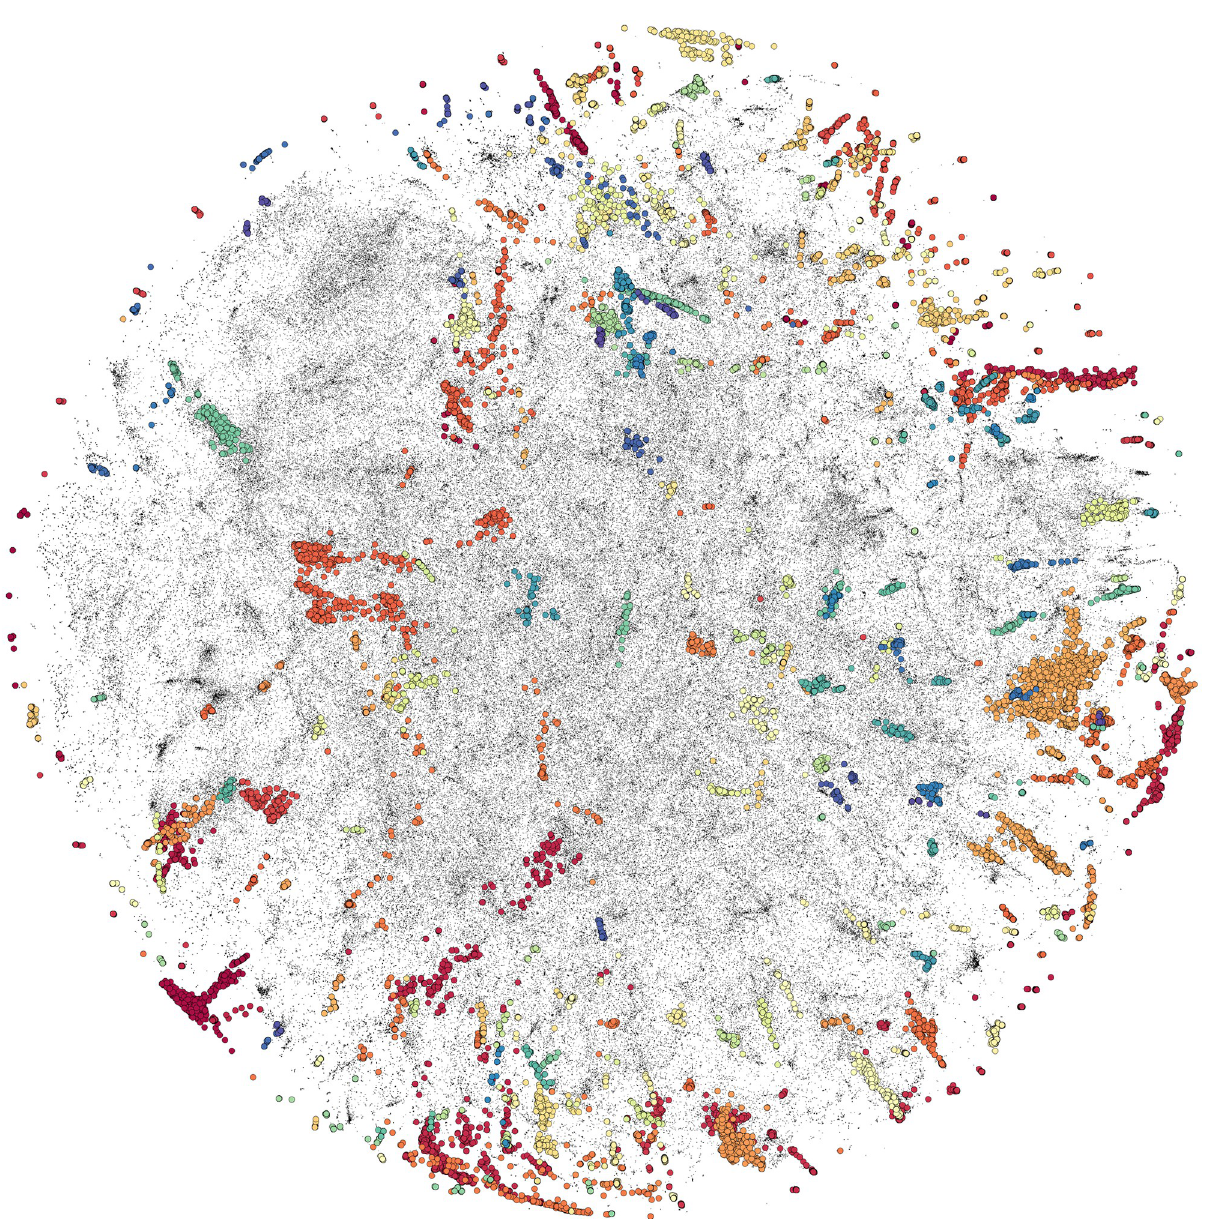
Fig 3. t-SNE projection of 577 K summary of product characteristics sentence embeddings, showing 284 clusters in colour coding and non- clustered items in black.